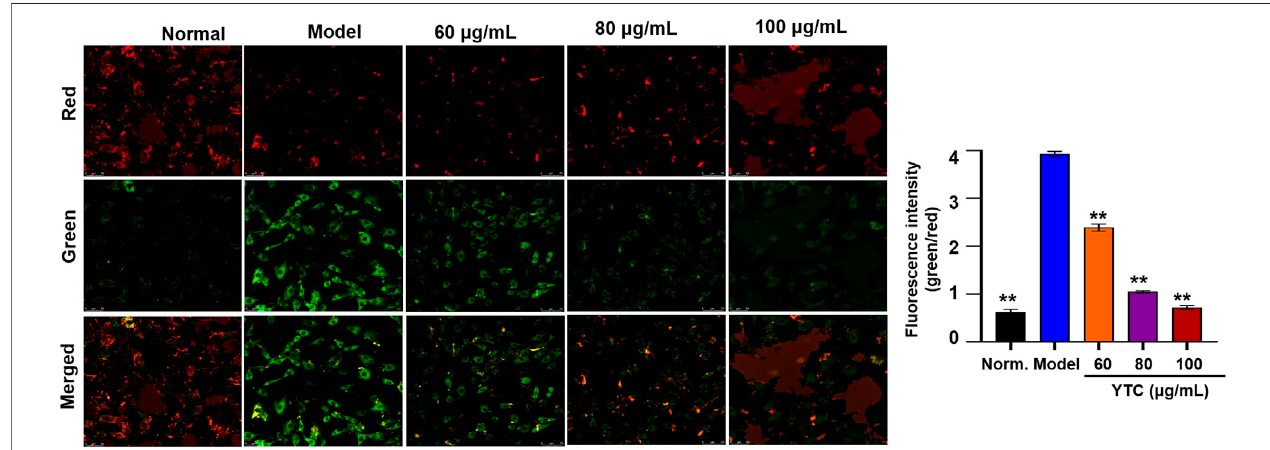
FIGURE 7 | Effects of YTC on the ΔΨ m in H9c2 cells (×40). Cells were pretreated with YTC (60, 80 and 100 μ g/ml) for 24 h, and then incubated in the presence of